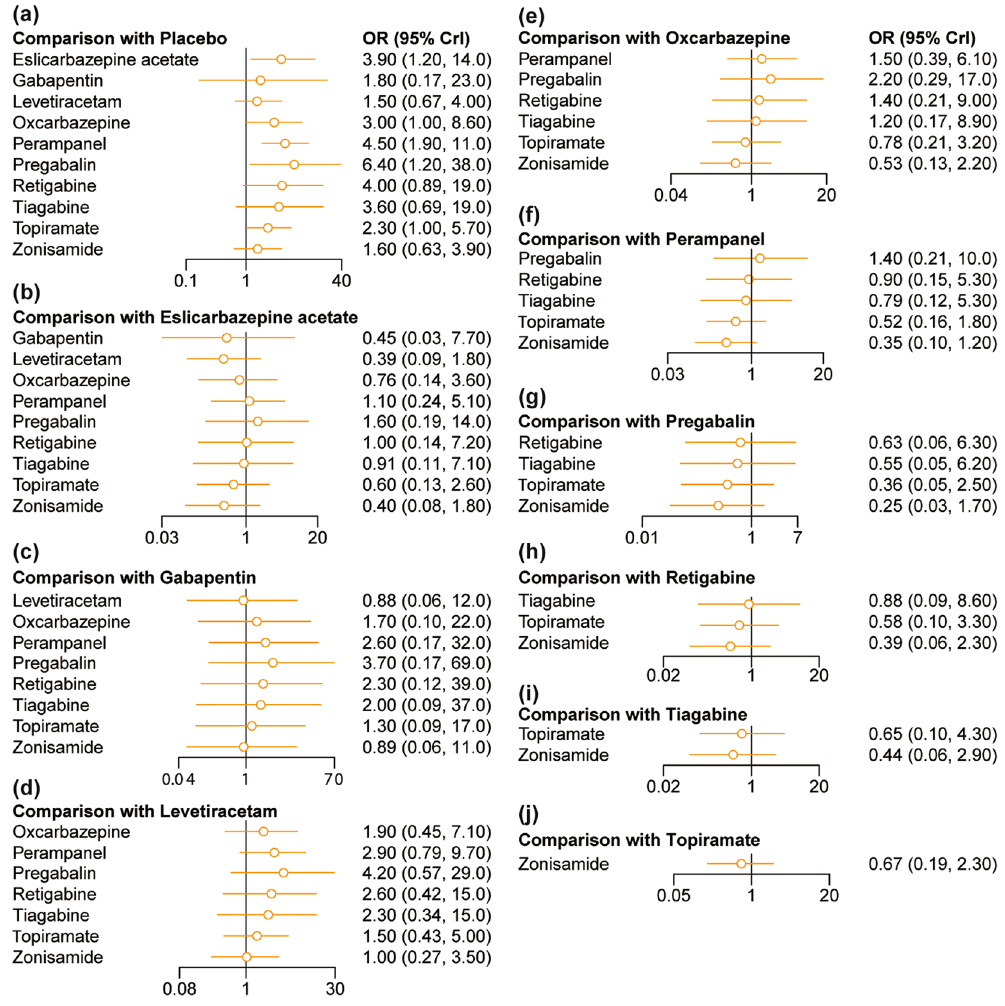
Figure 3. Forest plots for